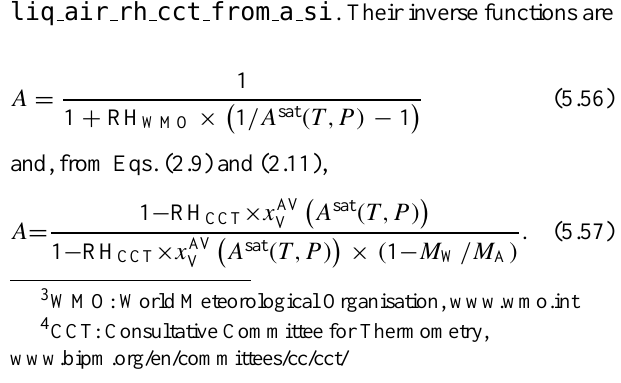
Fig. 8 Experimental data for the saturated vapour pressure expsat, P of humid air at Fig. 8. Experimental data for the saturated vapour pressure P sat , exp different pressures P and temperatures T as reported in (Feistel et al., 2010a), in of humid air at different pressures P and temperatures T as reported comparison to calcsat, P computed from Eqs. (5.53), (S21.9) and (S1.5). Symbol “o”: in (Feistel et al., 2010a), in comparison to P sat , calc computed from formula (2.7) without cross-virial coefficients, “B”: formula with the second cross- virial coefficient B AW ( T ), “C”: formula with the second and third cross-virial Eqs. (5.53), (S21.9) and (S1.5). Symbol “o”: formula Eq. (2.7) coefficients B AW ( T ), C AAW ( T ), C AWW ( T ). The smaller scatter is magnified in panel b). without cross-virial coefficients, “B”: formula with the second The improvement realized by including the C coefficients is effective mainly at densities higher than 100 kg m –3 . cross-virial coefficient B AW (T ) , “C”: formula with the second and third cross-virial coefficients B AW (T ) , C AAW (T ) , C AWW (T ) . The A practically important quantity is the relative humidity, RH , which expresses the deviation of smaller scatter is magnified in panel (b) . The improvement real- the air fraction A of a given sample of humid air from the saturation value A sat ( T , P ) belonging ized by including the C coefficients is effective mainly at densities to the same temperature and pressure, computed as the solution of Eq. (5.48) in the scenario higher than 100kgm − 3 of case 3 from Appendix A.10. Out of several options available from the literature, two different definitions are implemented and attributed here to the WMO 3 and to the CCT 4 ,